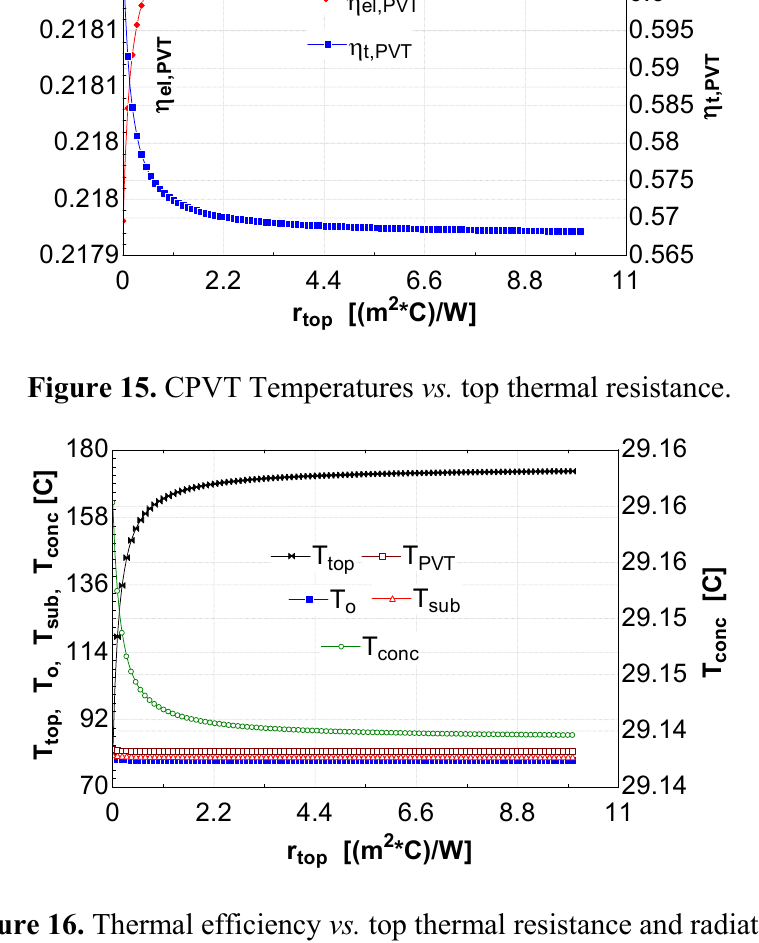
Figure 16. Thermal efficiency vs. top thermal resistance and